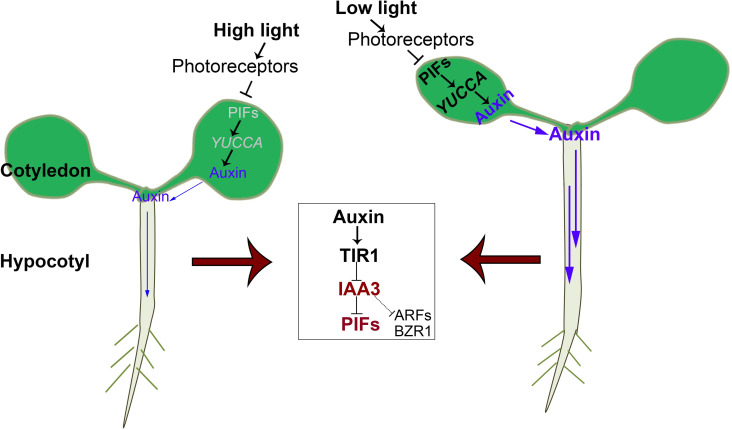
A working model of how different light conditions and auxin regulate seedling growth through the functions of IAAs and PIFs.The different responses of specific seedling tissues to changing light conditions and auxin reflect different patterns of IAA and PIF activity in these tissues. In young leaves, low light is perceived by photoreceptors and then triggers the accumulation of PIFs, leading to increased YUCCA expression and auxin abundance. The auxin in the leaves is transported to the hypocotyl, in which IAA3 is degraded through the TIR1-mediated proteasome pathway, releasing the inhibition of several transcription factors including PIFs, ARFs, and BZR1. The target genes of these transcription factors are activated to promote hypocotyl elongation. When the light conditions are sufficiently high, PIF accumulation in the leaves is reduced, leading to decreased YUCCA expression, and then reduced auxin levels in the leaves. Thus, the auxin in the hypocotyl which is transported from leaves is also reduced. Consequently, IAA3 represses PIFs, ARFs, and BZR1 in the hypocotyl. The blue arrows in the diagram represent auxin flow and the thickness of the arrows represent auxin level.